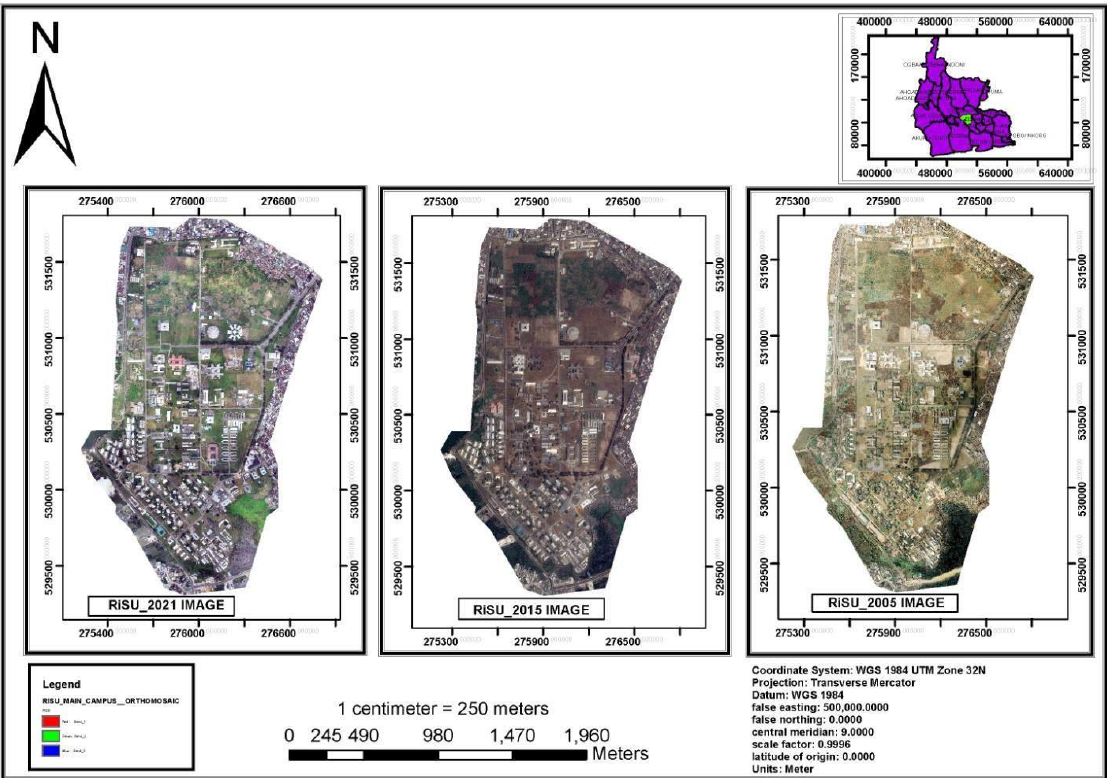
Figure 4: Composite Imageries of Rivers State University Portharcourt campus, 2021, 2015 and 2005.